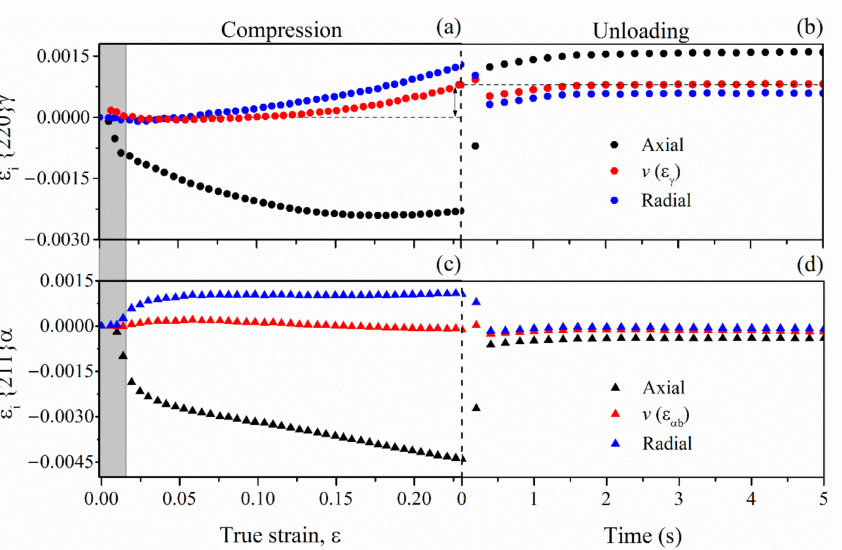
Figure 4. Lattice strains during DT in austenite ( a , b ) and bainitic ferrite ( c , d ) as a function of strain and after unloading as a function of time at 500 ◦ C. “ v ( ε γ )” and “ v ( ε α b )” denote the lattice strains of austenite and bainite considering the Poisson’s ratio, respectively. (Color figure